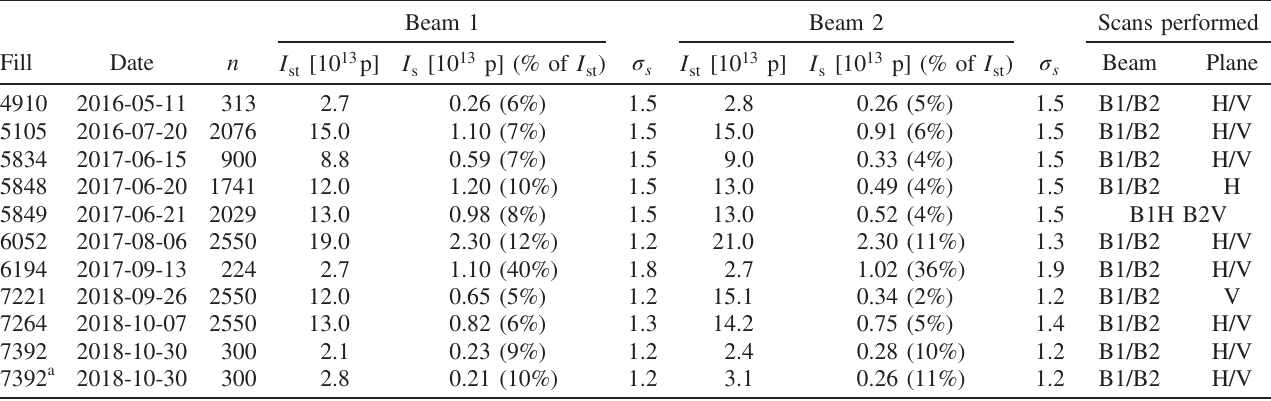
TABLE III. Summary of the measurements performed at 6.5 TeV, where n is the total number of bunches, I start of the scraping, and I is the total intensity lost during scraping (including luminosity burnoff). σ s is the scraped range in measured s beam sigma starting from 5 σ